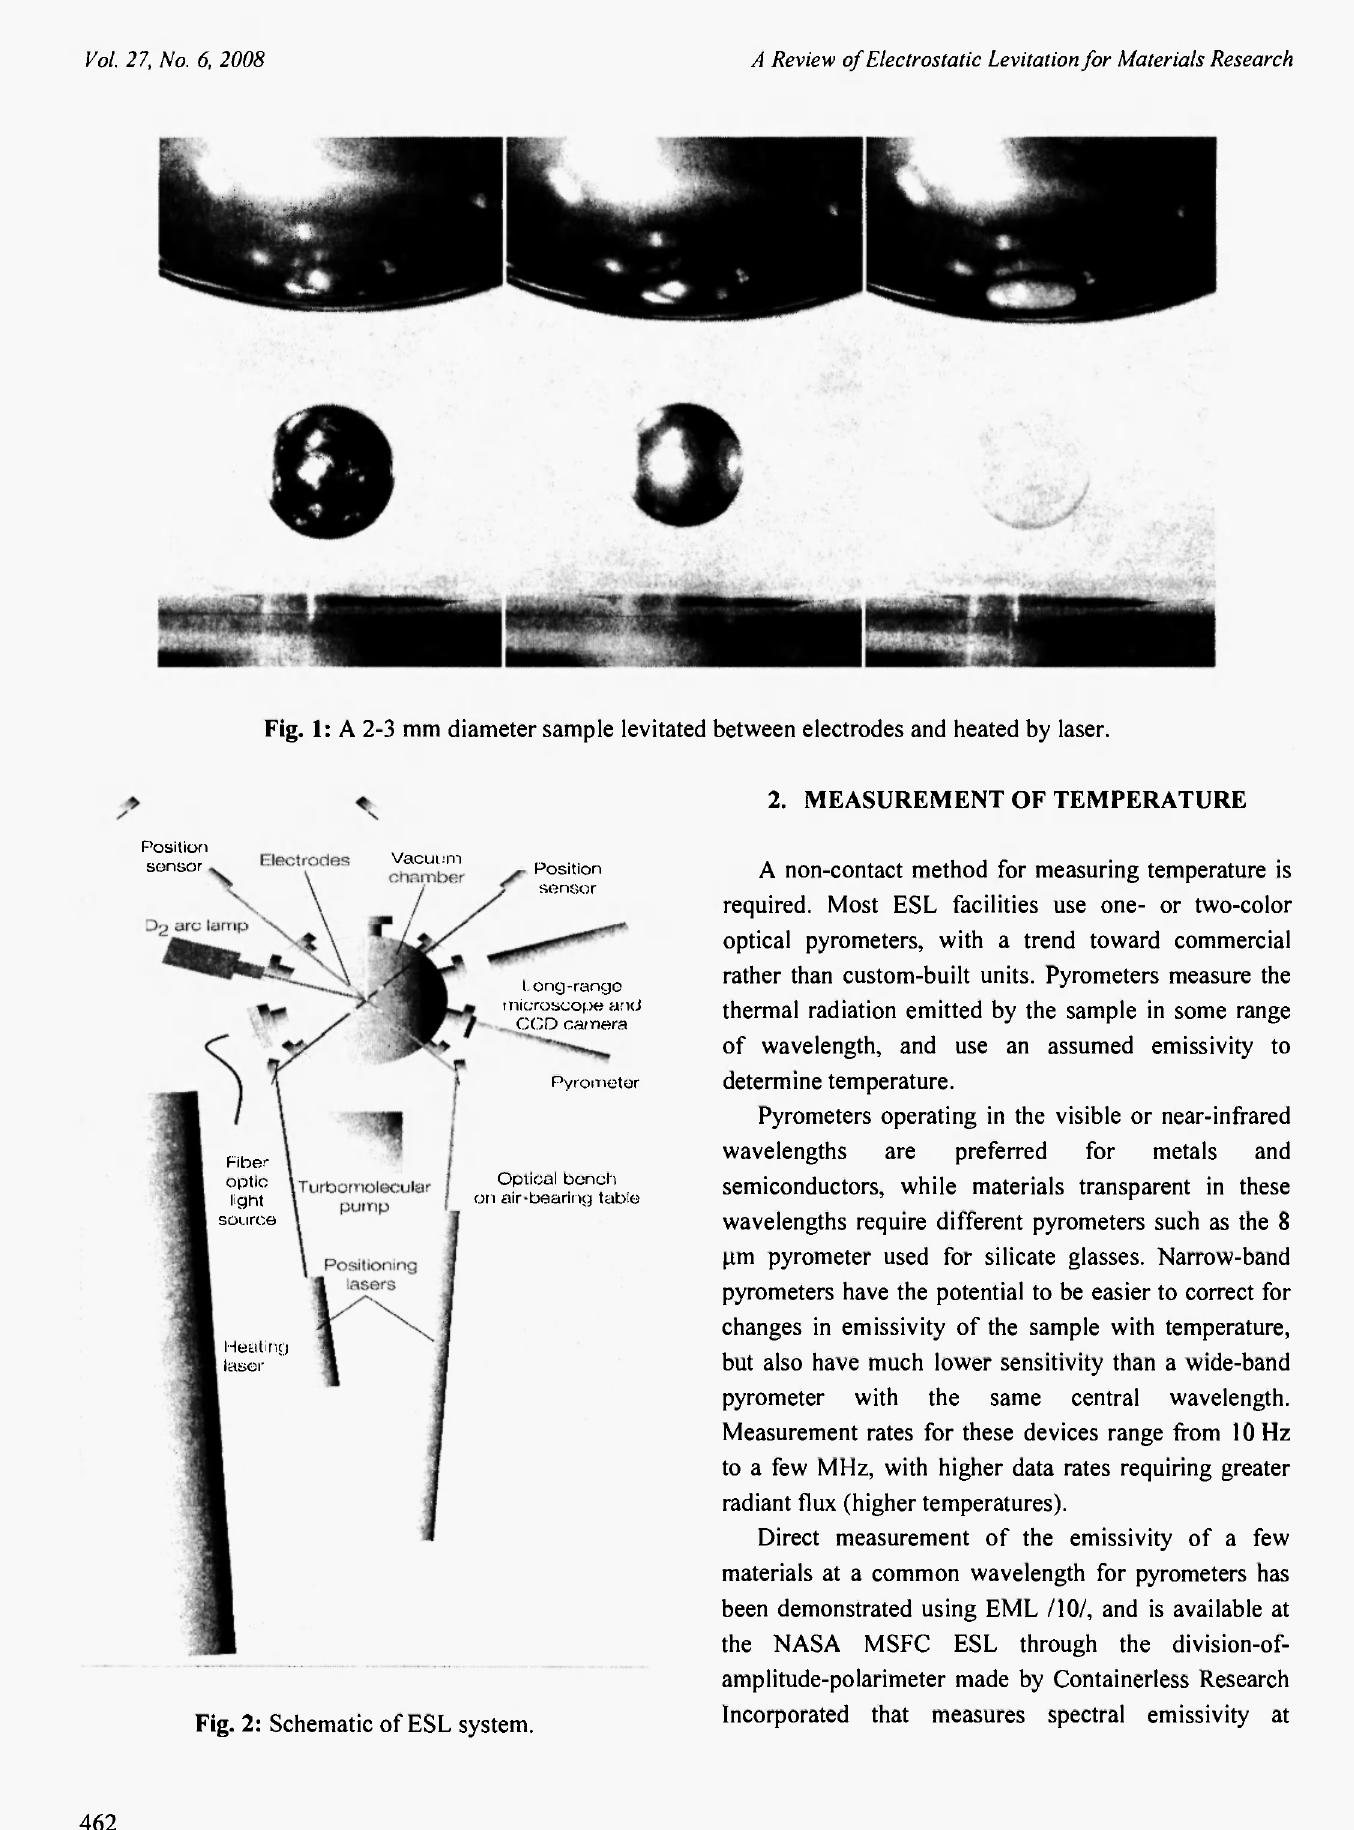
Fig. 2: Schematic of ESL system.